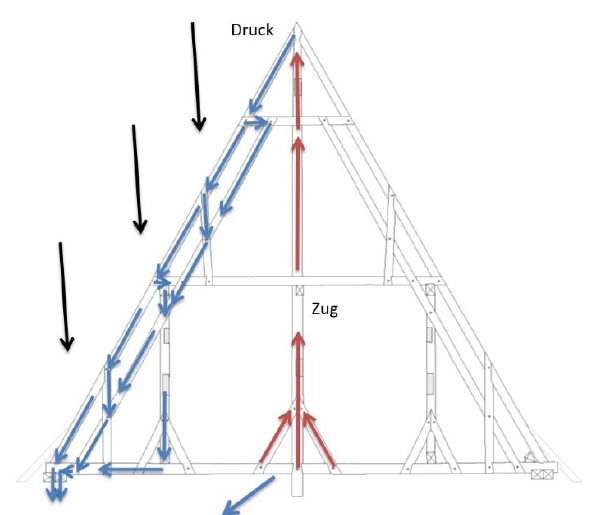
Figure 11. load transfere of tensile (red) and compressive (blue) force, principle rafter truss of the nave St. Michael’s Church,